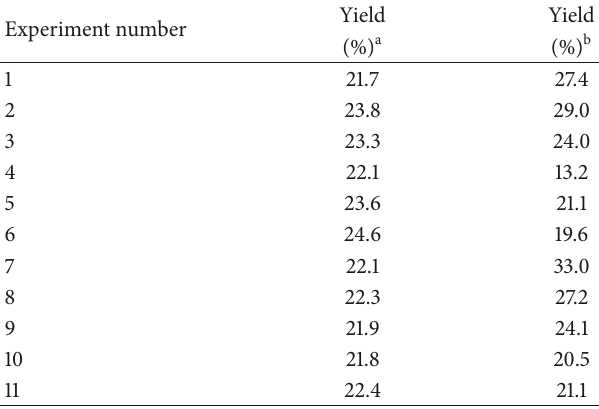
Table 2: Mucilage yields from O. cochenillifera obtained via thermal